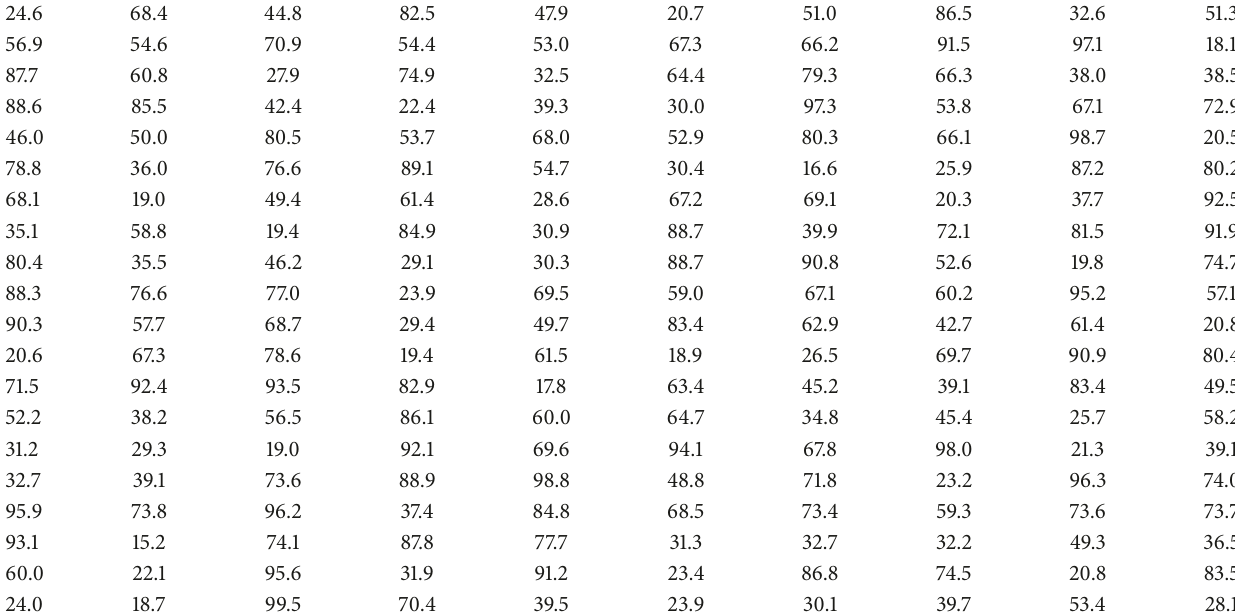
Table 2: The ages of the 200 units from the current population to be